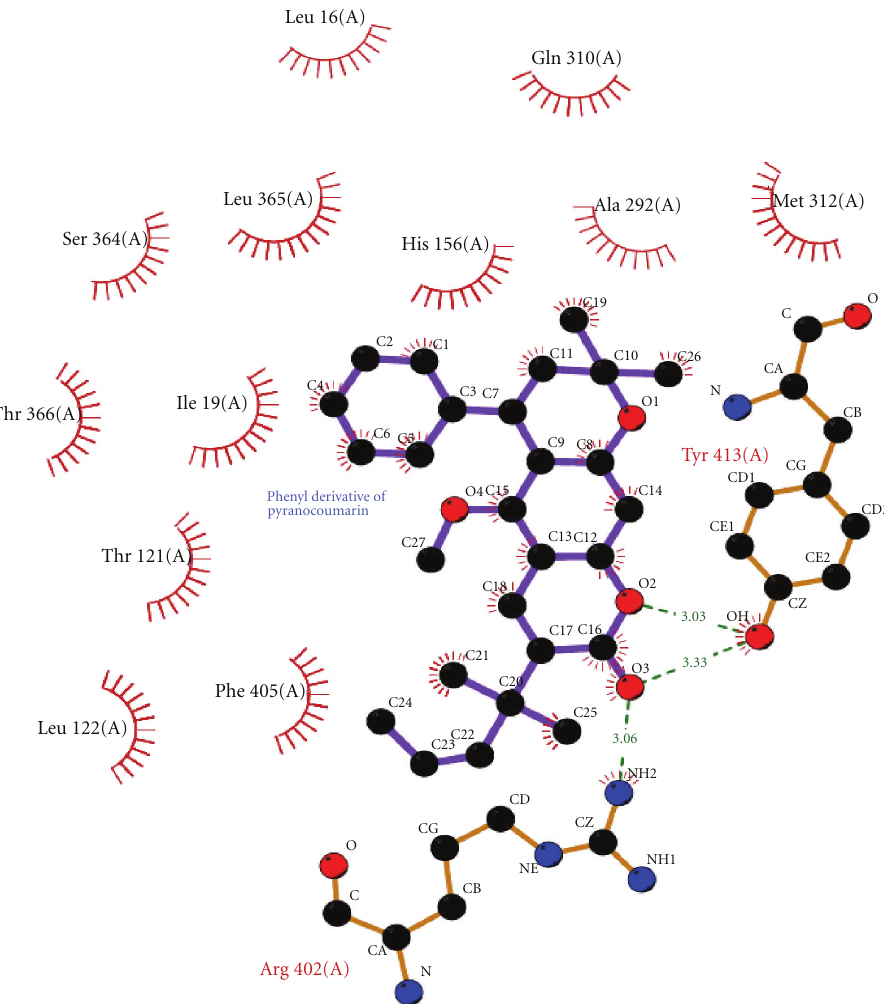
Figure 4: Ligplot image of interaction between PDP with trichothecene 3-O-acetyltransferase. Green dotted lines are hydrogen bond interactions and red semicircles are the hydrophobic